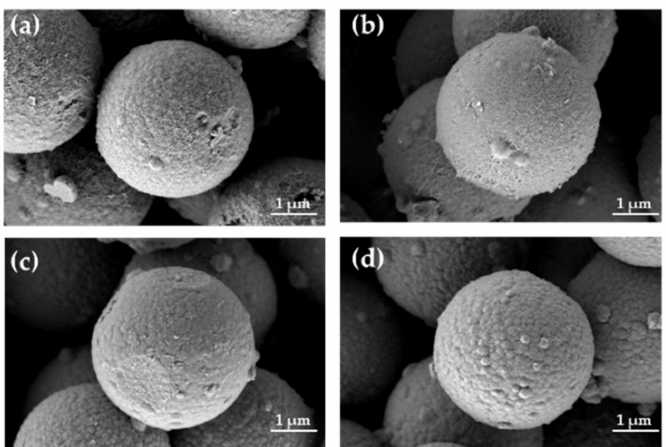
Figure 13. Image of conductive ball surface, changed according to metal coating reaction time: ( a ) surface image of conductive ball after 10 min of reaction time, ( b ) surface image of conductive ball after 20 min of reaction time, ( c ) surface image of conductive ball after 30 min of reaction time, and ( d ) surface image of conductive ball after 40 min of reaction